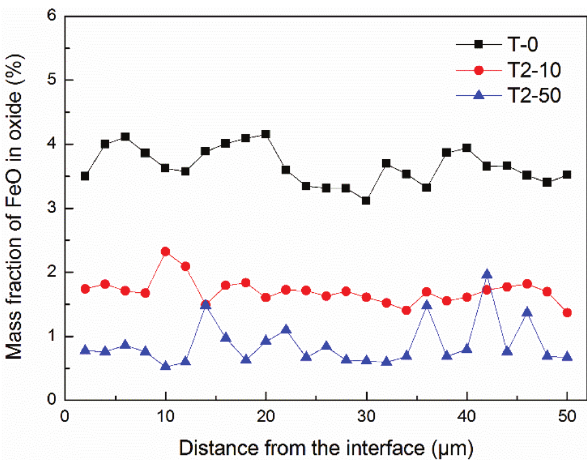
Figure 8: Concentration profiles of FeO content in the oxide near the interface after heat treatment at 1273K.